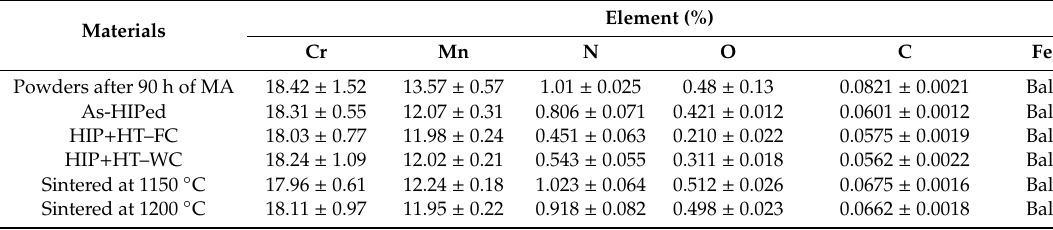
Table 4. Bulk chemical composition of the tested materials.